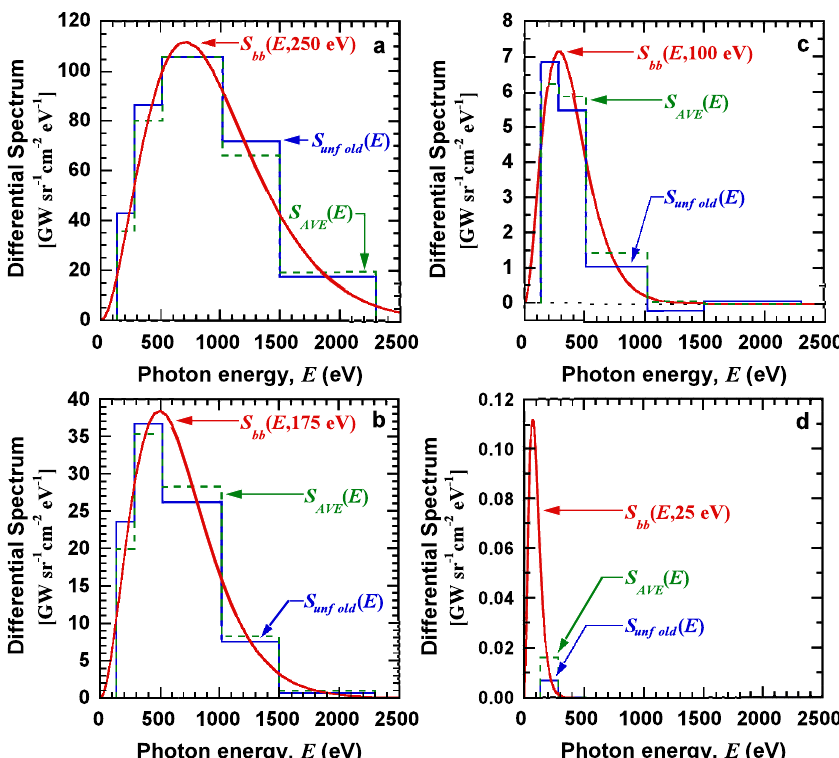
ð E; T Þ of noted spectral temperatures, bin-averaged spectra S ð E Þ , and FIG. 8. Comparison of four Planckian test spectra S bb AVE ð E Þ . Here, S ð E Þ reasonably approximates S for T ¼ 250 , 175, and 100 eV (rms closeness measures 0.18, unfolded spectra S bb unfold AVE ð E; 25 eV Þ [rms closeness (cid:3) 0 : 98 ]. Unfolded spectra S ð E Þ from correspond- 0.23, 0.33, respectively) but poorly approximates S bb unfold ð E Þ down to T ¼ 100 eV (c), where a negative unfold value is obtained ing data simulations show general binwise agreement with S AVE (cid:7) . There is also significant disagreement between S ð E Þ and S ð E Þ for S ð E; 25 eV Þ (cf. Table in bin ½ (cid:1) E bb 4 AVE unfold